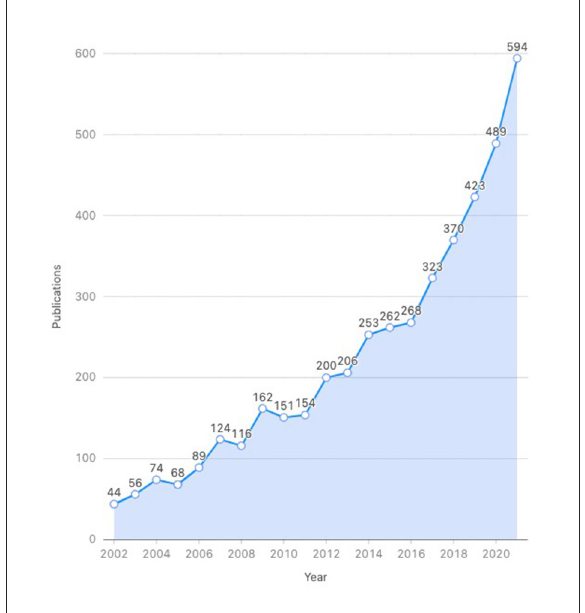
FIGURE1 Annual number of publications about CPET.